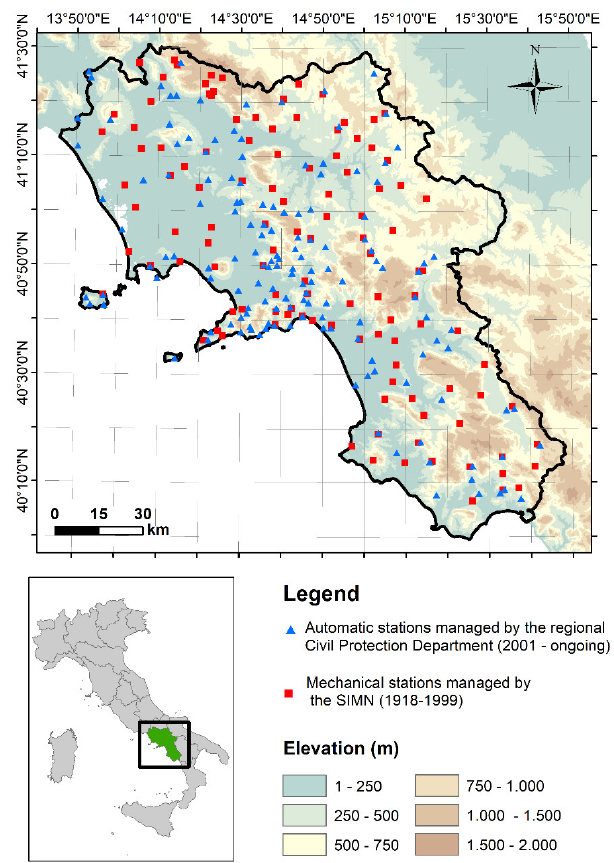
Figure 1. Elevation map of the Campania region with locations of rainfall monitoring stations.